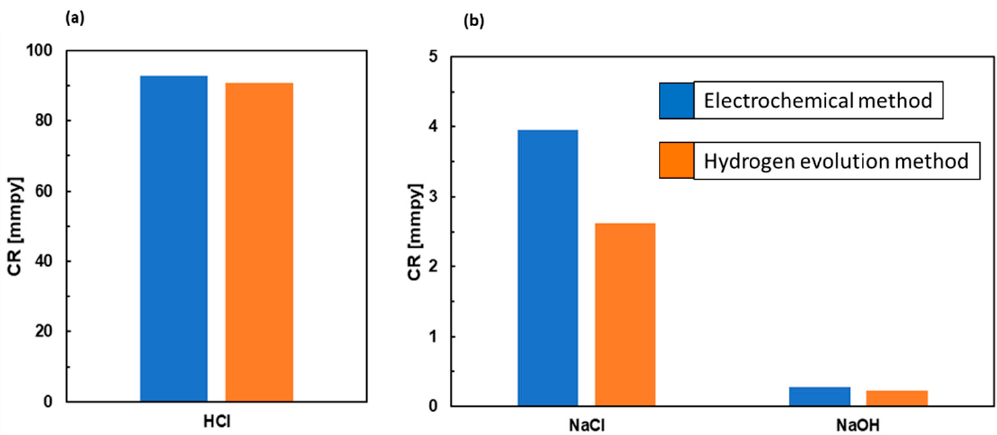
Figure 10. Corrosion rates of the Mg 2 Sn alloy in aqueous HCl ( a ), NaCl and NaOH solutions ( b ).